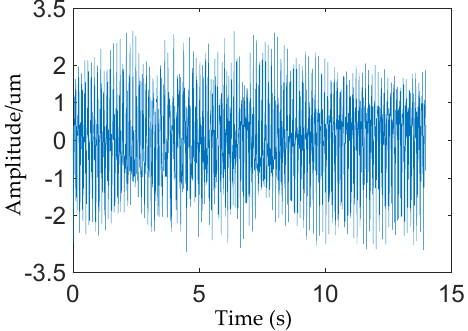
Figure 1. Time-domain waveform of the simulated signal.